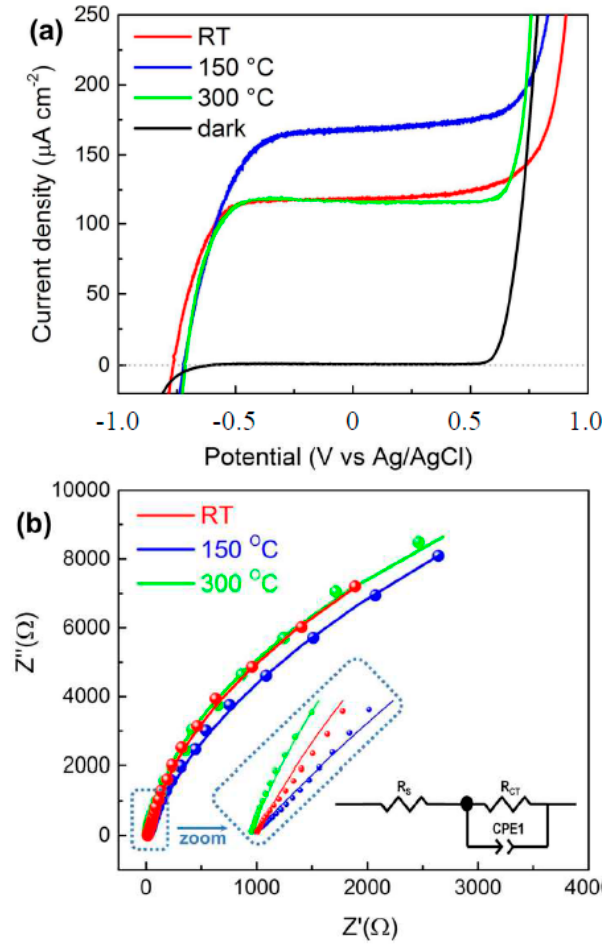
Figure 7. Linear sweep voltammetry curves of the TiO 2 nanotubes ( a ). Nyquist plots for TNT-RT, TNT-150, and TNT-300 measured at an applied bias potential of 0 V vs. Ag/AgCl under illumination of AM1.5G with the intensity of 100 mW cm − 2 ( b ). Symbols are experimentally measured impedance data; solid curves are fitted to the equivalent circuit shown (inset). R s is solution resistance, R CT is charge transfer resistance, Constant phase element (CPE1) is capacitance element. Photoelectrochemical (PEC) measurements were carried out in 1 M NaOH electrolyte under simulated solar light irradiation (air mass-AM1.5G, 100 mW/cm 2 ).